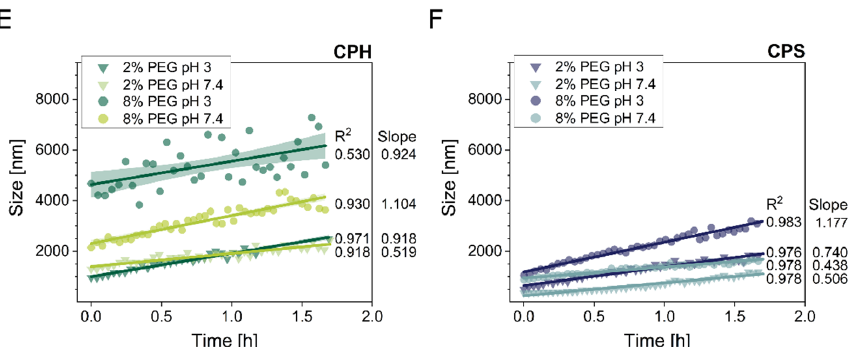
Figure 2. Polystyrene particle characterization. The functionalized polystyrene particles, sulfated (CPS) and hydroxylated (CPH), were characterized prior to the chromatographic experiments. ( A , B ) show the size distribution and electrophoretic mobility, expressed as zeta potential, of CPH (green, striped) and CPS (blue) at varying pH (and 0% PEG 8000 ). Additionally, the particles were supplemented with 0.03% polysorbate 20 (Tween 20) (black triangle and circle, respectively). Visualized are the measurements directly after the sample preparation at t = 0 min. The data shows the mean of n = 3 and standard deviations as error bars. ( C – F ) present the size distribution kinetics of the pH- and PEG 8000 -dependent particle aggregation behavior analyzed over a period of 2 h. The data shows the means of n = 2. ( E , F ) depict linear fits for the presented kinetics, including all generated data points, with the respective R 2 and slopes. The lines represent the fits, while the hatched areas indicate the 95% confidence intervals. Data in ( E , F ) partly overlaps with the data shown in ( C , D ), but is included to facilitate the